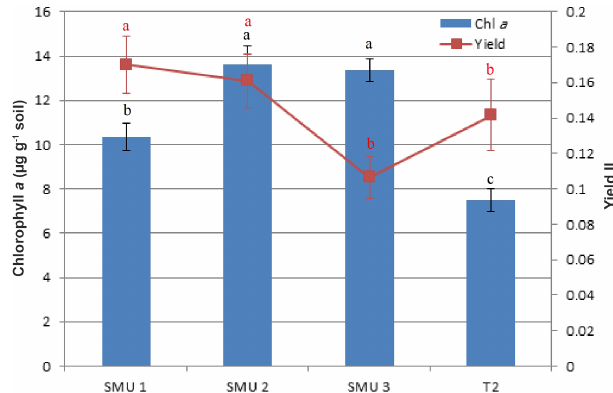
Figure 3. Chlorophyll a concentration (µgg − 1 soil) following res- urrection (2 weeks) after a natural desiccation (dry) period of 6 months. Soil management units: SMUs 1–3 and T2 (2-year-old topsoil stockpile); photosynthetic yield (YII) of photosystem II (PSII), with mean values and standard error of the mean (SEM). Different letters indicate significant differences between